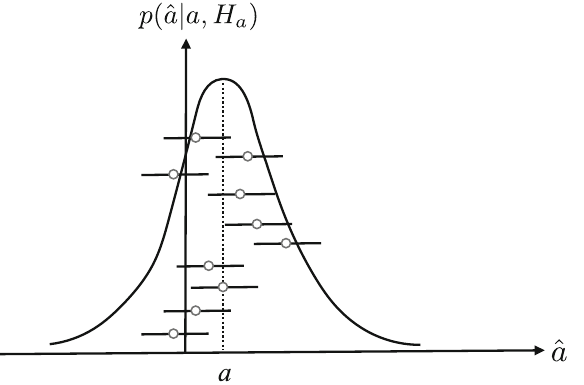
Fig. 6 Definition of the frequentist confidence interval for parameter estimation. Each circle and line represents a measured interval [ˆ a − Δ , ˆ a + Δ ] . The set of all such intervals will contain the true value of the parameter a (indicated here by the dotted vertical line ) CL ∗ 100% of the time, where CL is the confidence